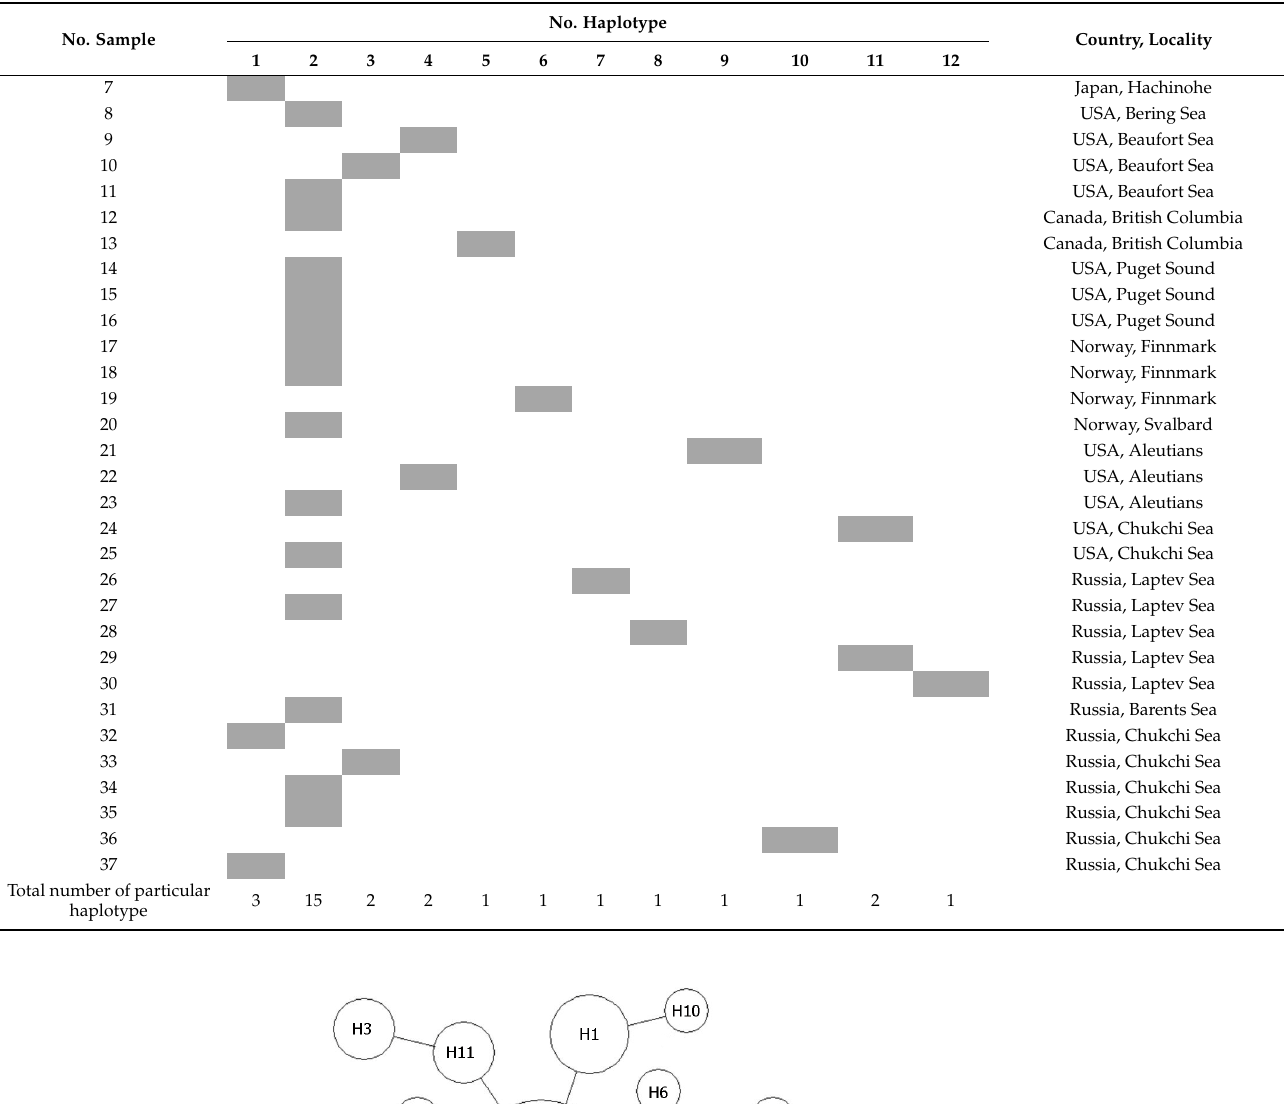
Table 4. Composition of CO1 haplotypes in the studied walleye pollock Gadus chalcogrammus samples. Numbers of samples correspond to Table 2.